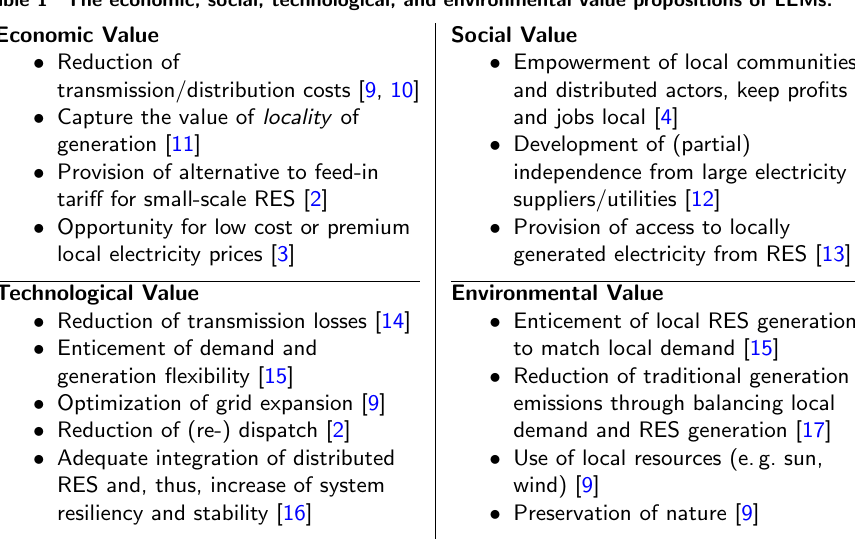
Table 1 The economic, social, technological, and environmental value propositions of